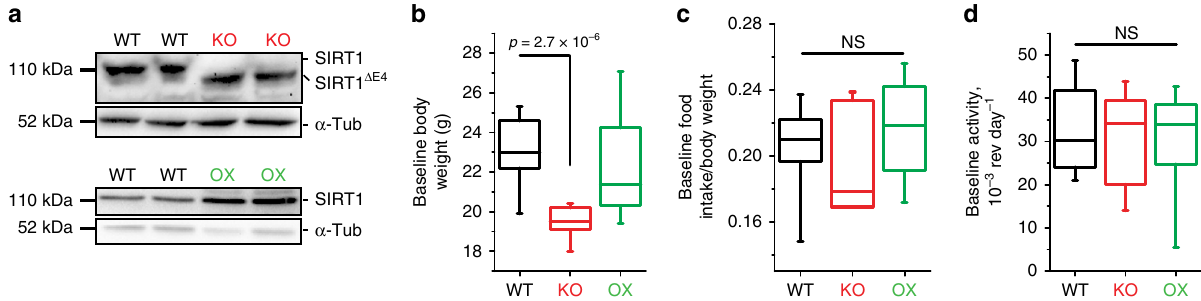
Fig. 1 SIRT1 BSKO and BSOX baseline phenotypes. a Brain-speci fi c knockout (BSKO) mice lack functional SIRT1 in the brain, while the brain-speci fi c overexpressing (BSOX) mice overexpress SIRT1 in the brain. This is representative of three independent experiments. b BSKO mice (red) are signi fi cantly smaller than their littermates, while there are no differences between WT (black) and BSOX (green) mice. c , d No differences were observed in baseline food intake or activity of WT, BSKO, or BSOX mice. P values were calculated using unpaired two-tailed t tests. The box-plots represent the median, 25th, and 75th percentiles of the data and the whiskers represent 5 – 95% of the data. Six mice were used in each cohort. NS, not signi fi cant. Source data are provided as a Source Data fi